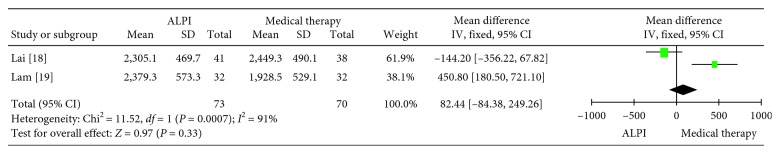
Forest plot showing the endothelial cell count. ALPI: argon laser peripheral iridoplasty.